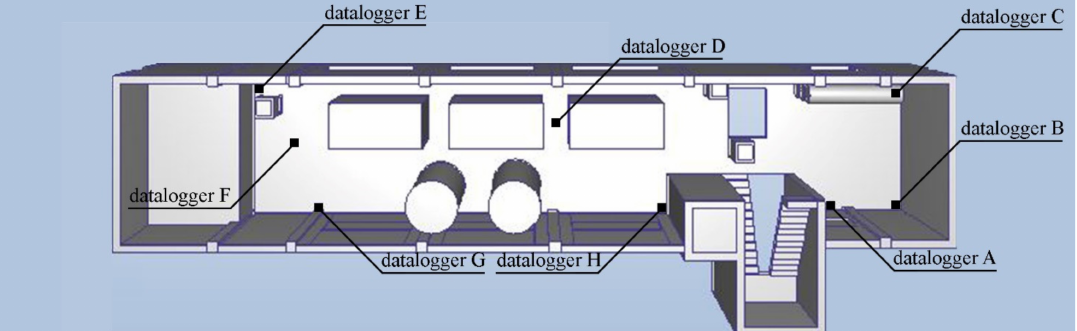
Figure 3. Positions of data-loggers used for the monitoring of indoor air